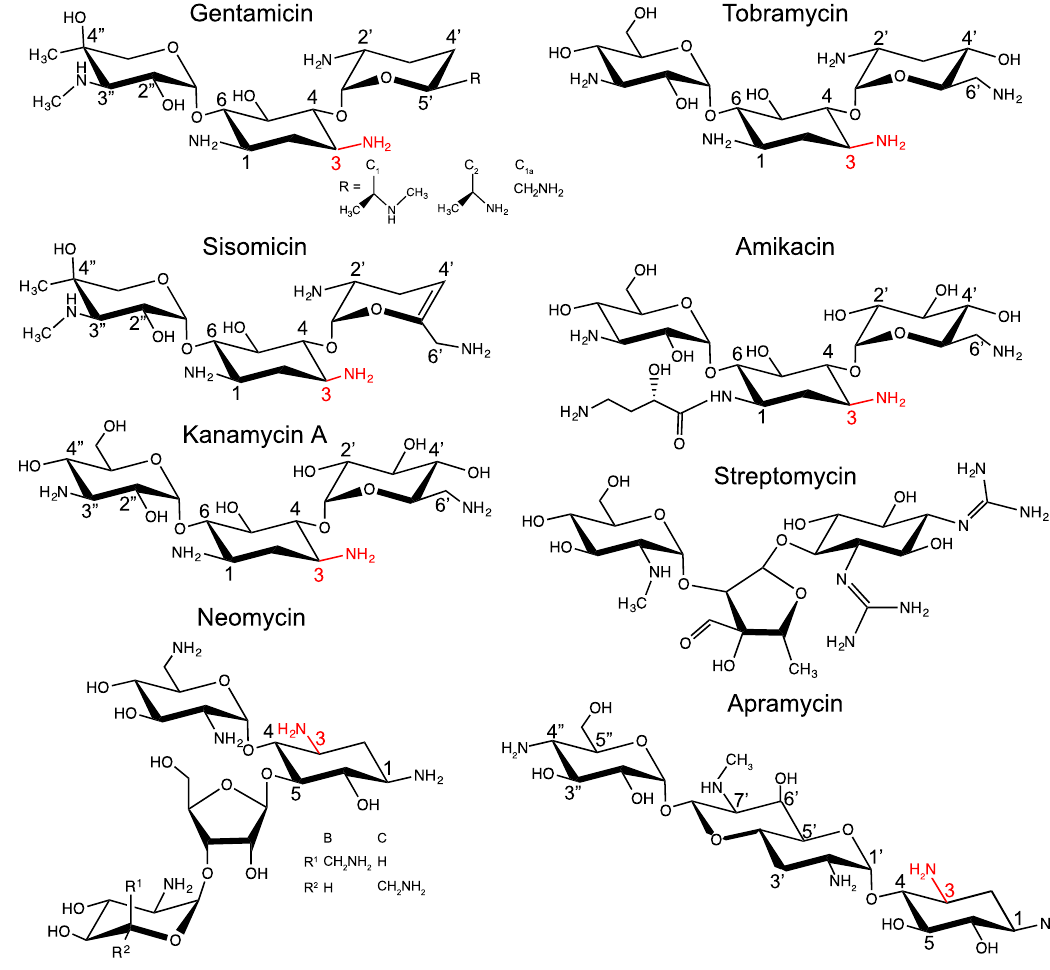
Fig. 1 Chemical structures of aminoglycosides. The 3-amino group is highlighted in